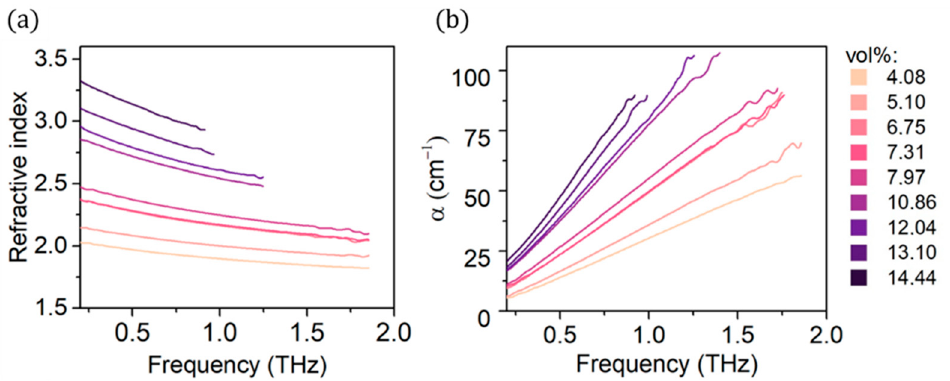
Figure 4. ( a ) Refractive index and ( b ) absorption coefficient of EBA/CB composites.